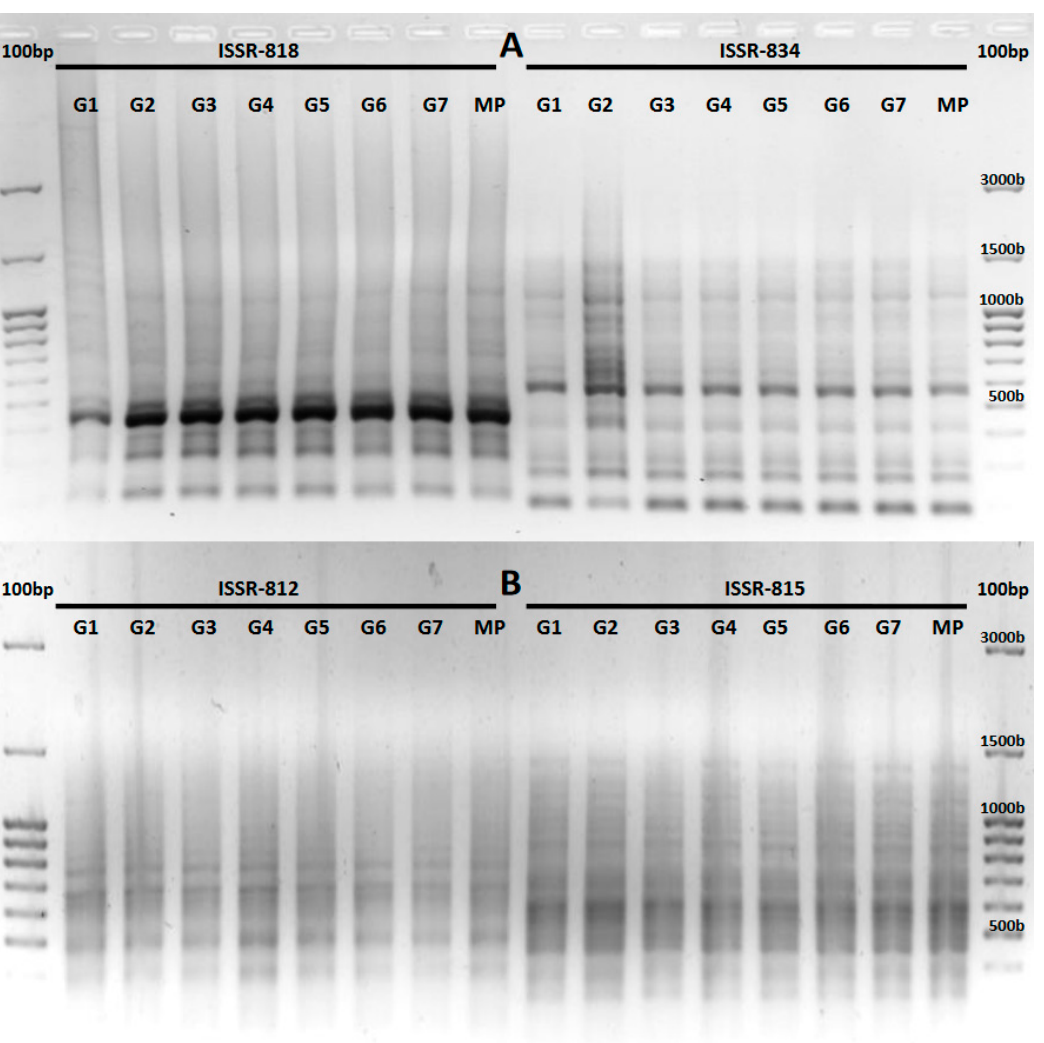
Table 7. Sequence of 10 Inter Simple Sequence Repeat (ISSR) primers used to determine the genetic stability of V. dentatum plantlets produced from encapsulated shoot tip explants.